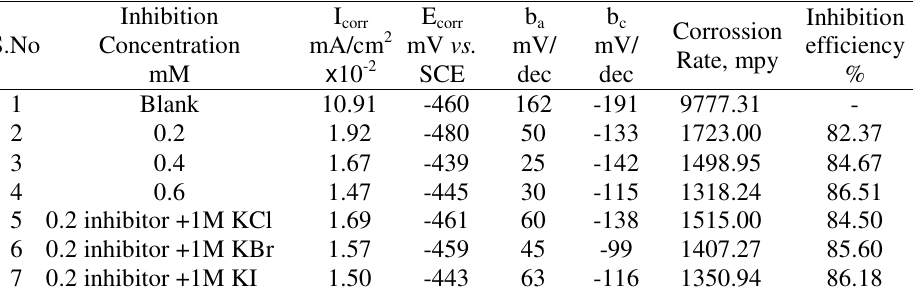
Table 6. Potentiodynamic polarization parameters for the corrosion of mild steel in 1 M H SO with and without 2 4